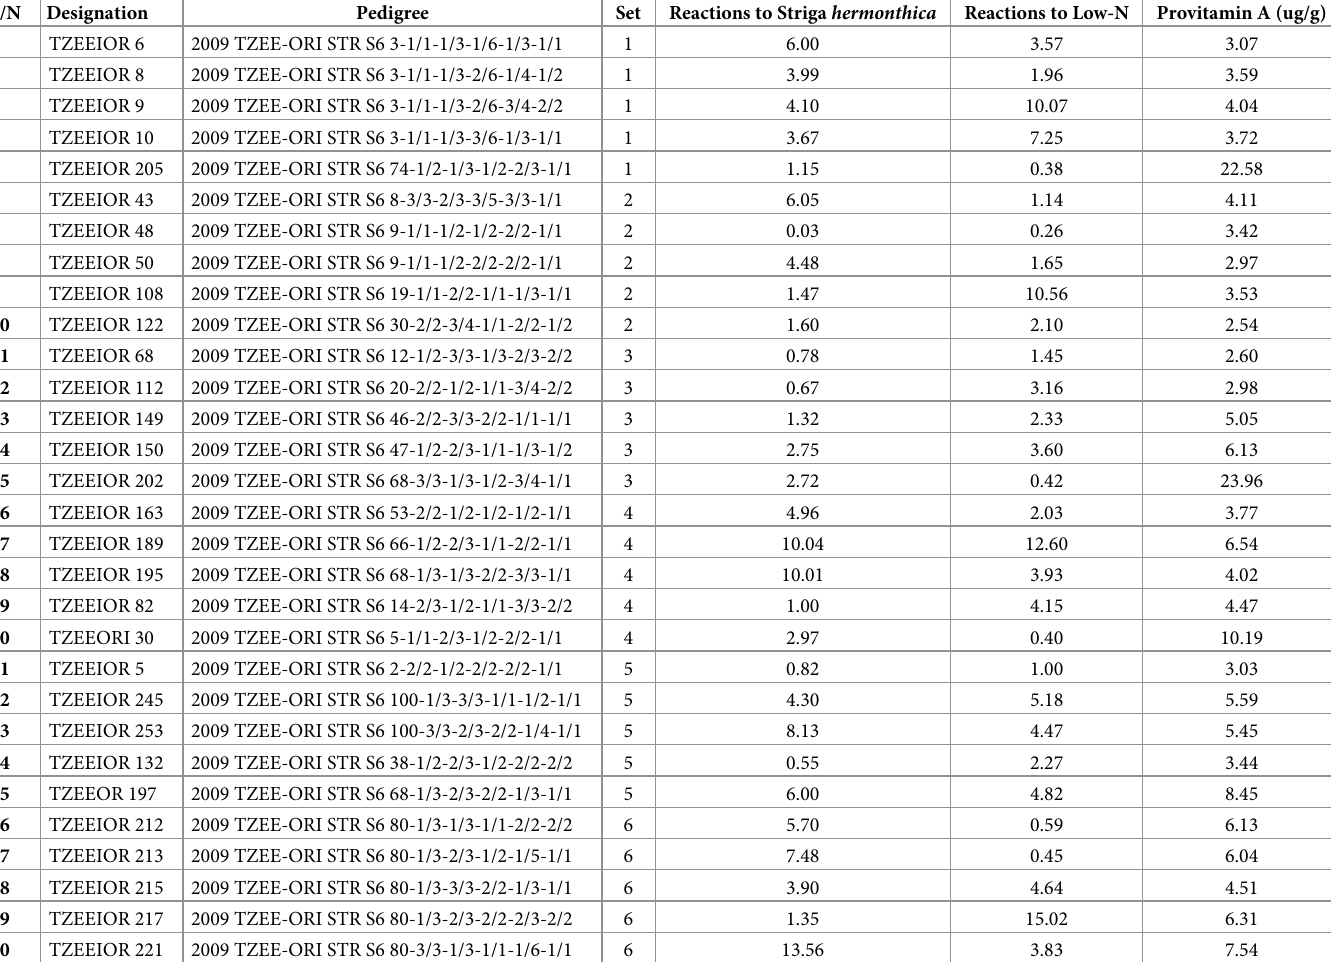
Table 1. List of the extra-early maturing PVA maize inbred lines used for the North Carolina design II studies, the pedigree information, reactions to Striga and provitamin A contents in preliminary studies.